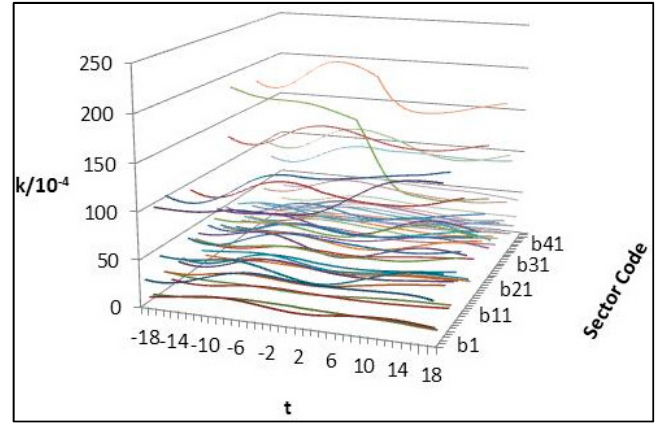
Figure 4. Kullback-Leibler (KL) divergence results of 46 Sectors.